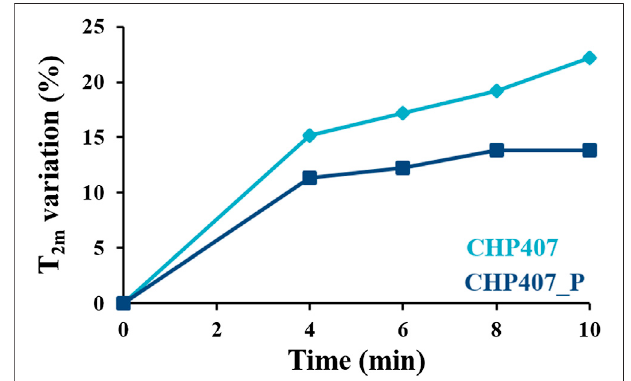
FIGURE 8 | Spin-spin relaxation time variation (%) respect to data measuredat time zeroasafunction oftime during temperature increase inthe range 4 ° C – 37 ° C for CHP407- and CHP407_P-based systems (light and dark blue,